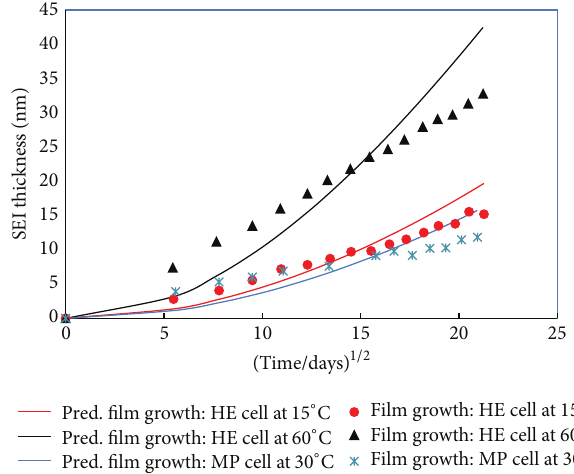
Figure 9: Percentage capacity loss versus time for Quallion LLC ATD test cell at 55 ∘ C.